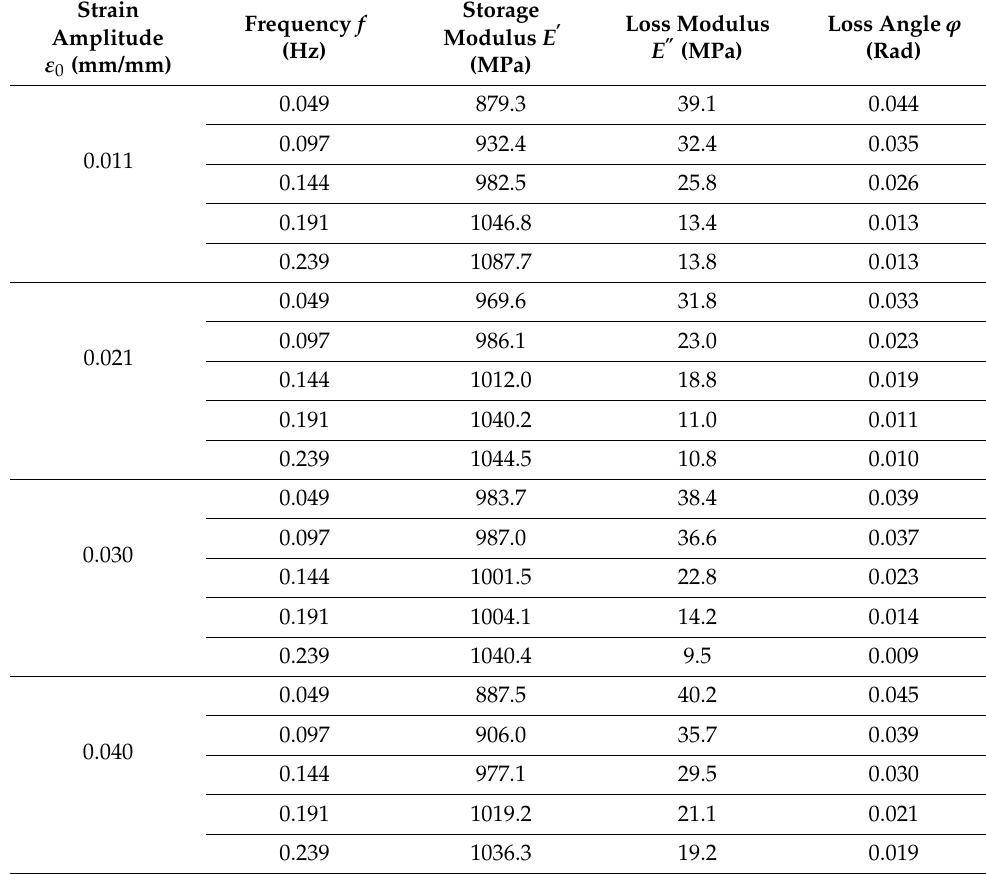
Table A2. Values determined in a cyclic compression